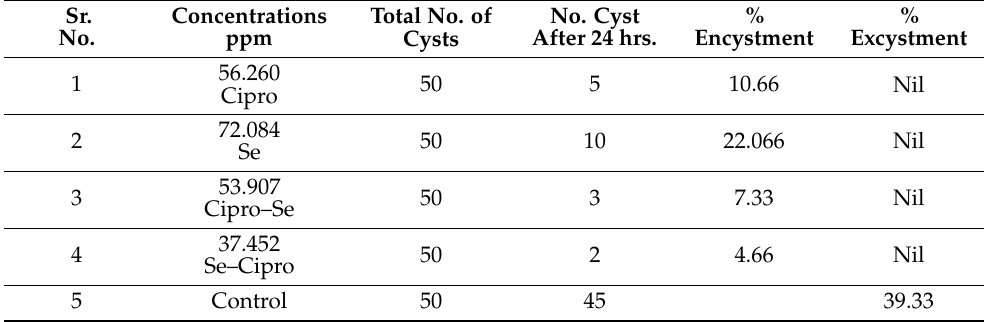
Table 2. Encystment and excystment at LC 50 concentration of nano-combinations and